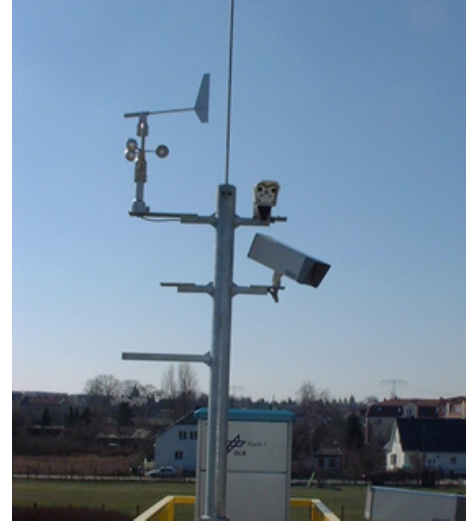
Figure 7: Weather